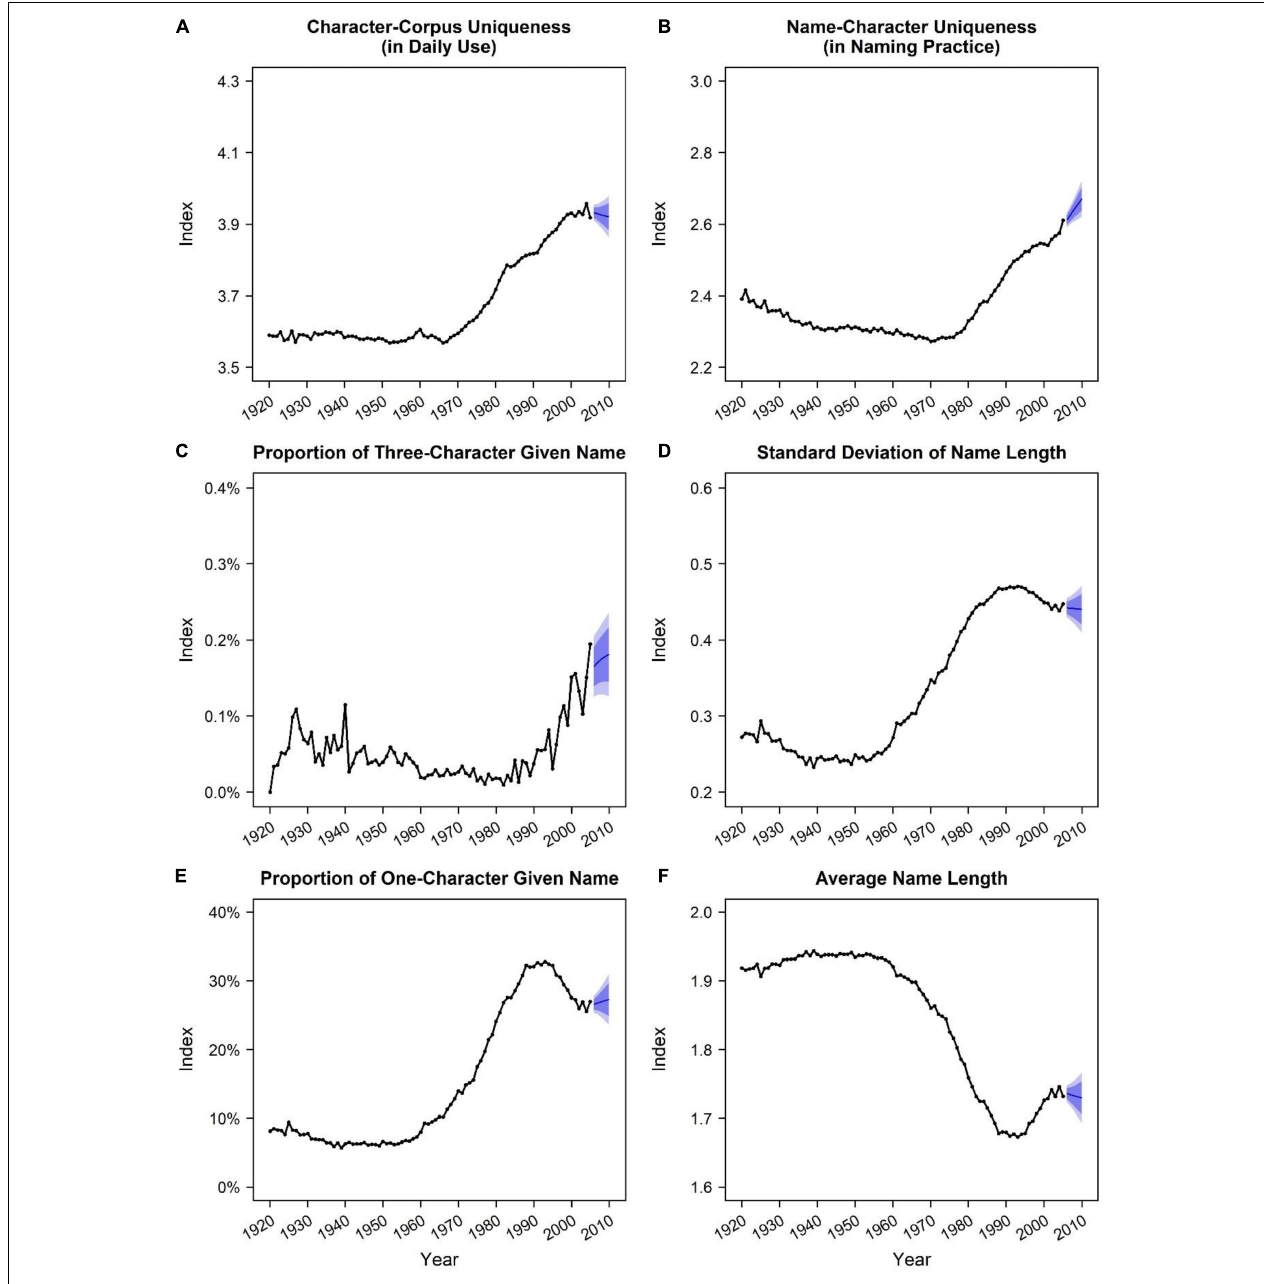
FIGURE 2 | Trends of six name indices in China (1920 ∼ 2005). We used the R package “forecast” to add potential changes from 2006 to 2010, as shown in blue lines with prediction intervals at 80 and 95% confidence levels. (A) Character-corpus uniqueness (in daily use) by year. (B) Name-character uniqueness (in